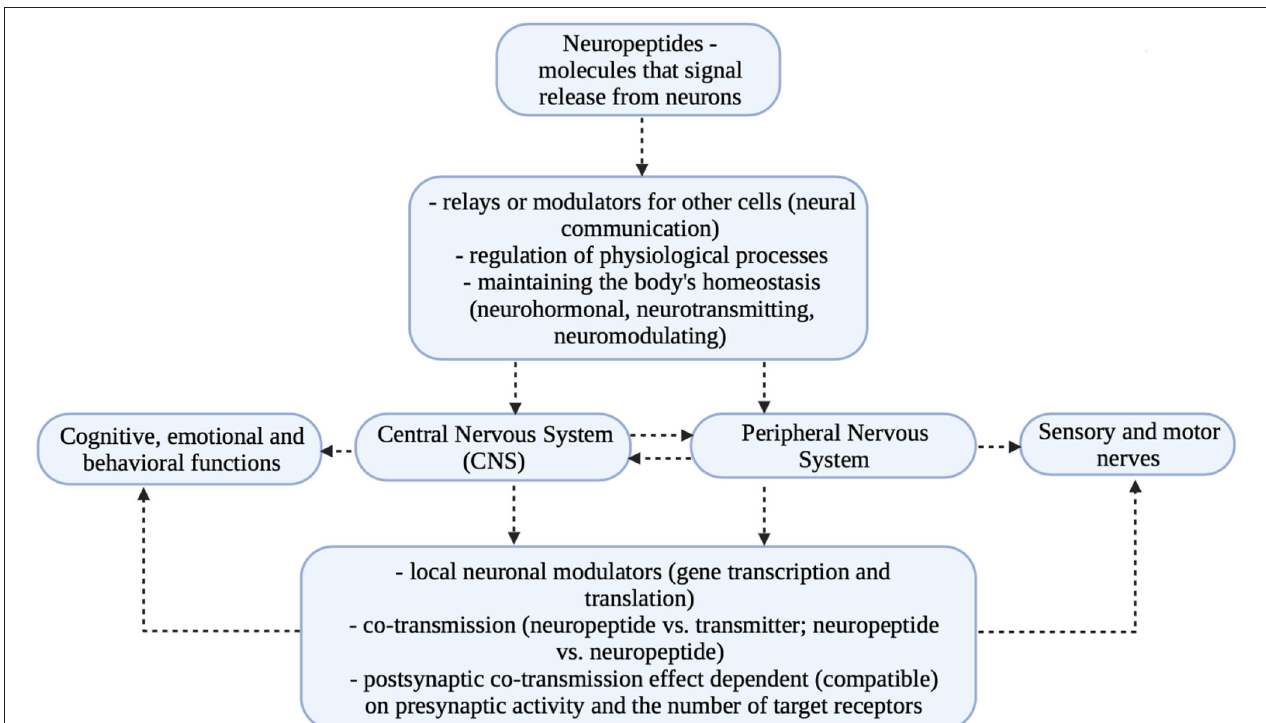
FIGURE 2 | Multifaceted action of neuropeptides (18,